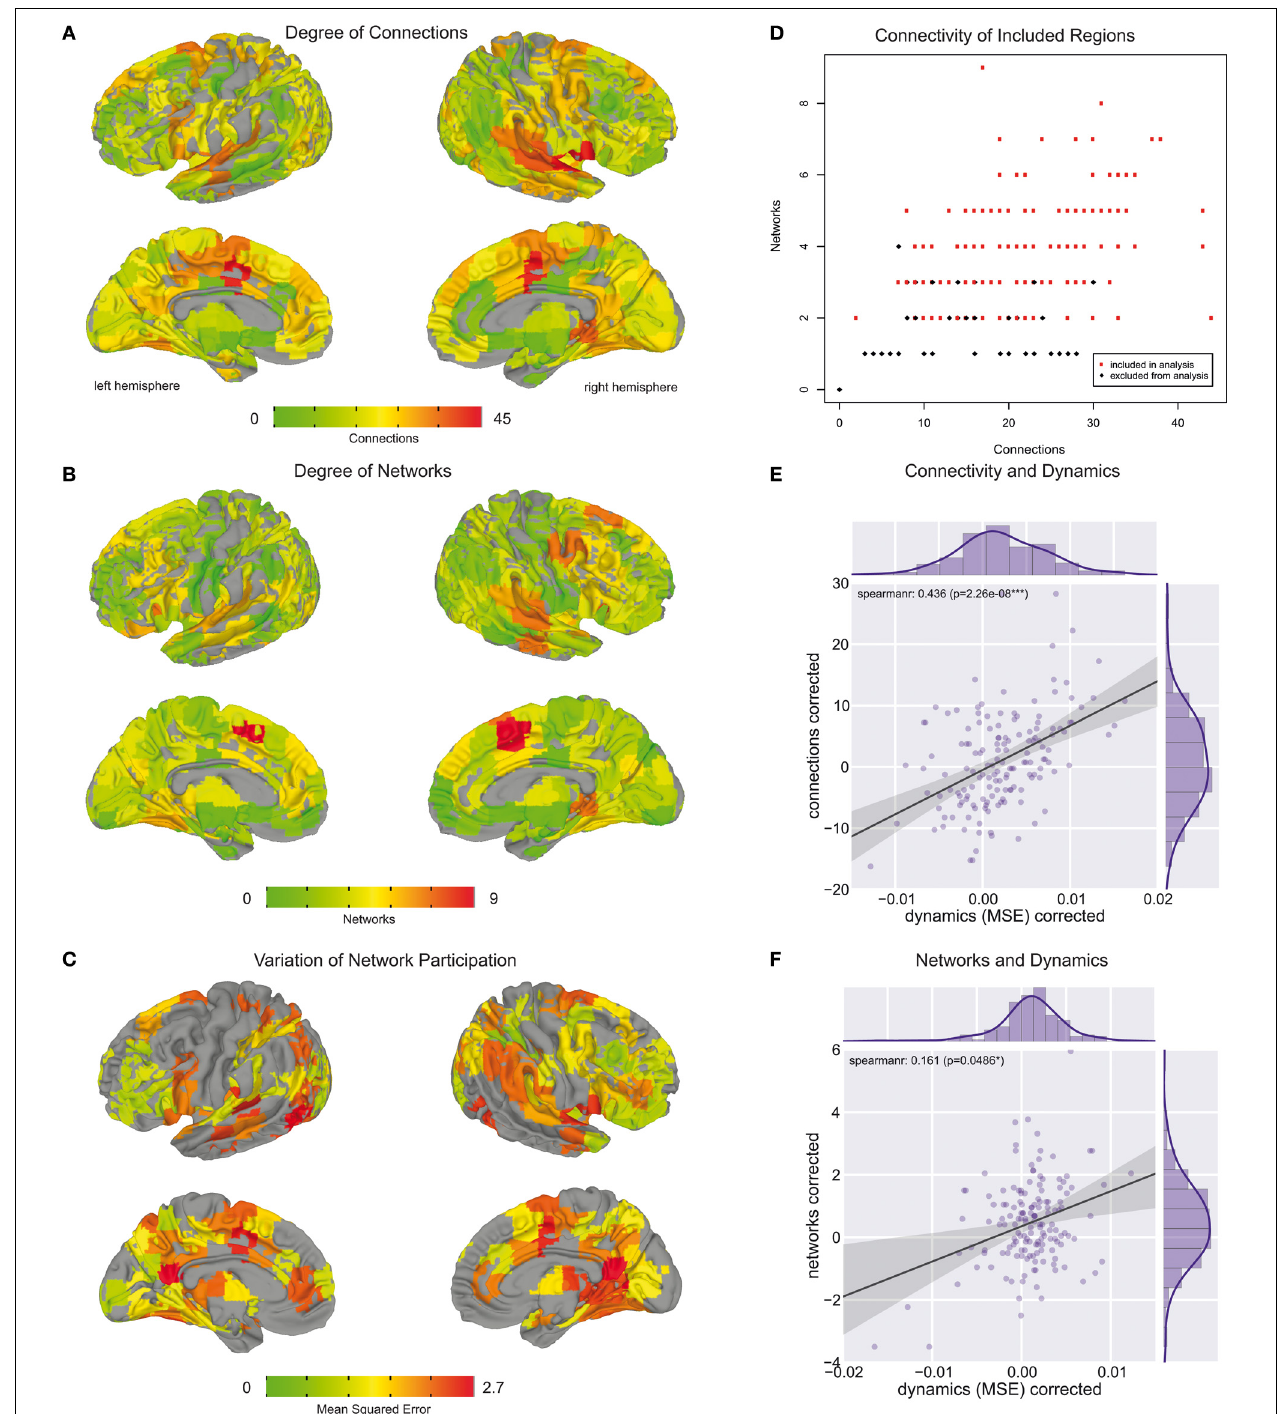
FIGURE 4 | Whole brain regional overview. (A) Brain areas colored by their degree of connectivity. Areas with more connections are displayed in red, whereas regions with fewer connections are in green. (B) Brain areas colored by the number of networks they are part of. Regions participating in a higher number of networks are displayed in red. Regions which are part of fewer networks are depicted in green. (C) Brain areas colored by their variation of network participation. Areas with higher variation are colored in red, whereas regions with lower variation are shown in yellow and green. (D) Relation